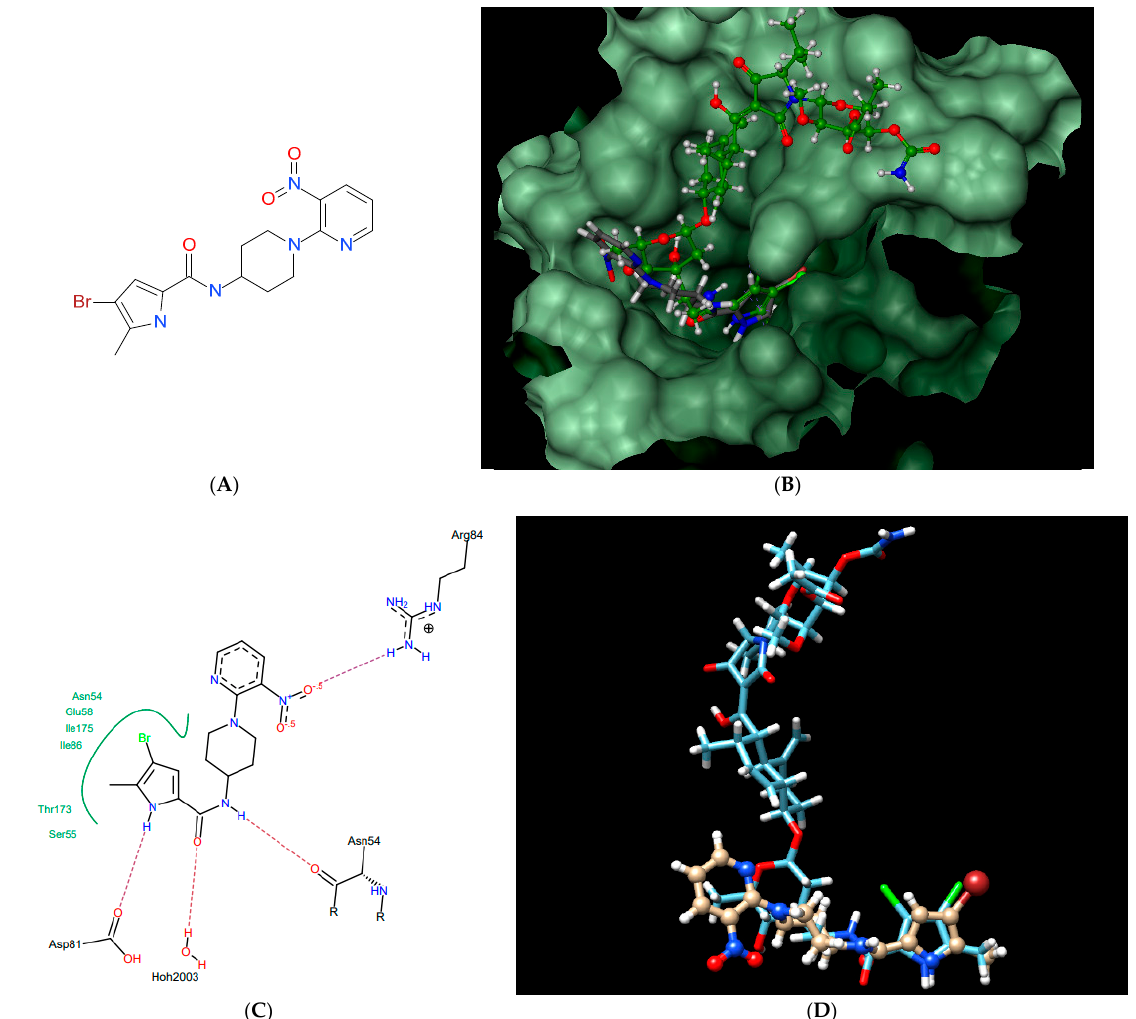
Figure 3. Pyrrolamide-based GyrB inhibitor: structure ( A ), best pose in binding to S. aureus GyrB (PDB entry: 4URM) ( B ), interactions with amino acids in the active site ( C ), and best pose overlaid with kibdelomycin ( D ).